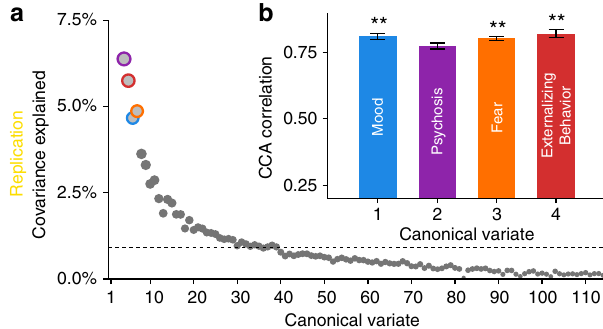
Fig. 8 Linked dimensions of psychopathology were replicated in an independent sample. All procedures were repeated in an independent replication sample of 336 participants. a The fi rst four canonical variates in the replication sample were selected for further analysis based on covariance explained. Dashed line marks the average covariance explained. b The mood, fear, and externalizing behavior dimensions were signi fi cant by permutation testing. Corresponding variates are circled in ( a ). Error bars denote standard error. ** P FDR <